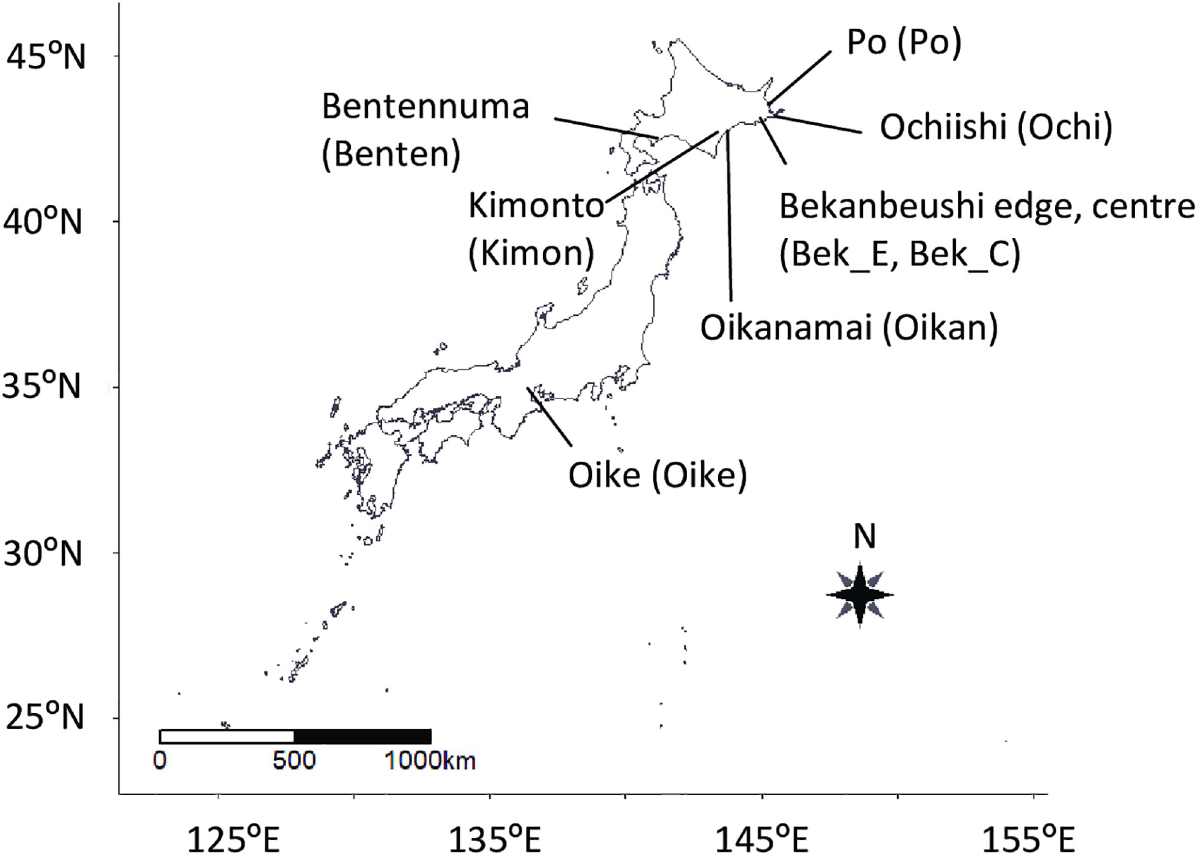
Fig 1. Study sites of Myrica gale populations. Abbreviations of the sites are shown in parentheses. Maps were created using Natural Earth. Free vector and raster map data @ naturalearthdata.com.